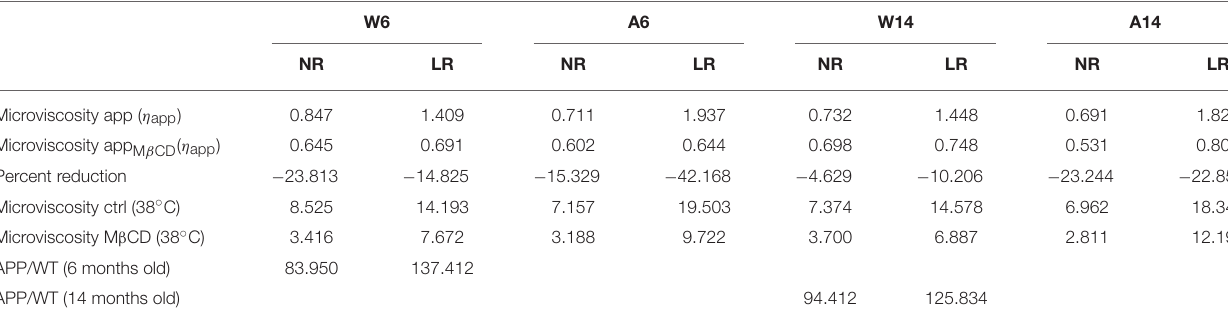
TABLE 4 | Microviscosity values ( η app ) of lipid rafts (LR) and non-rafts (NR) domains proved with DPH.